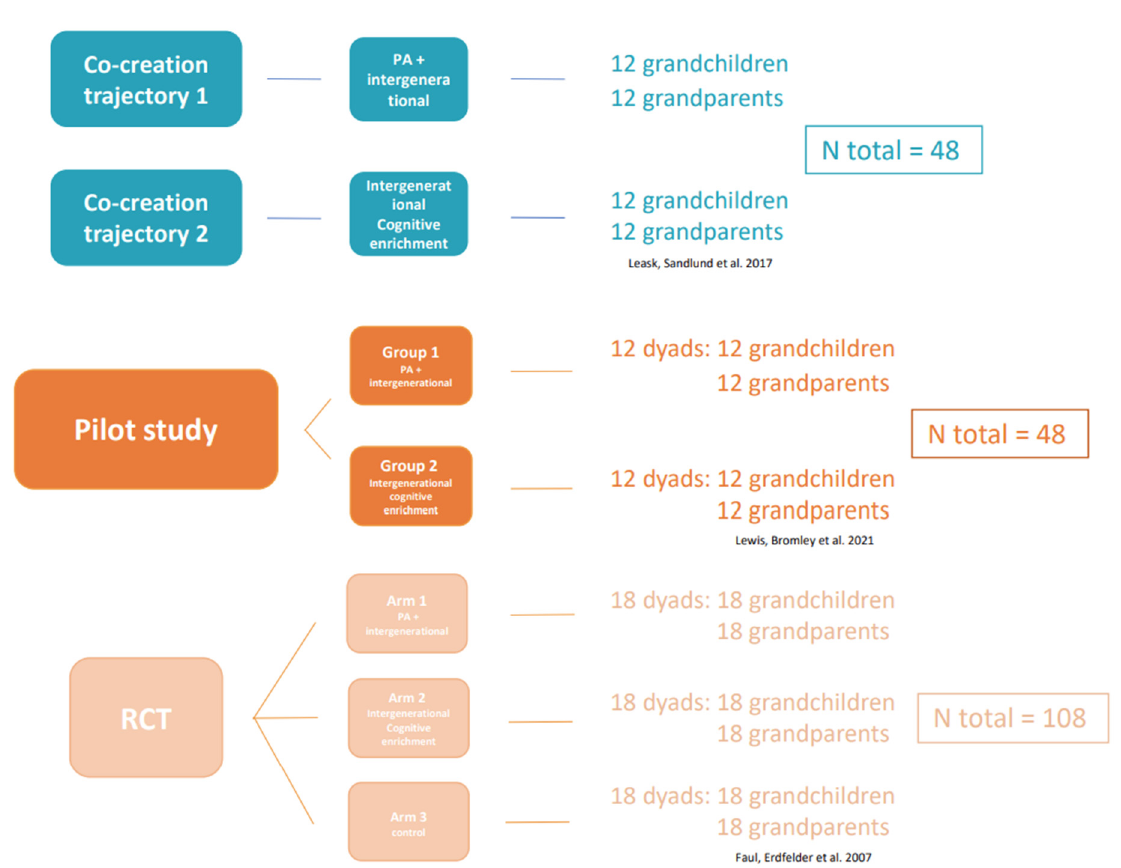
Figure 4. Overview of the study design and number of participants [58–60].